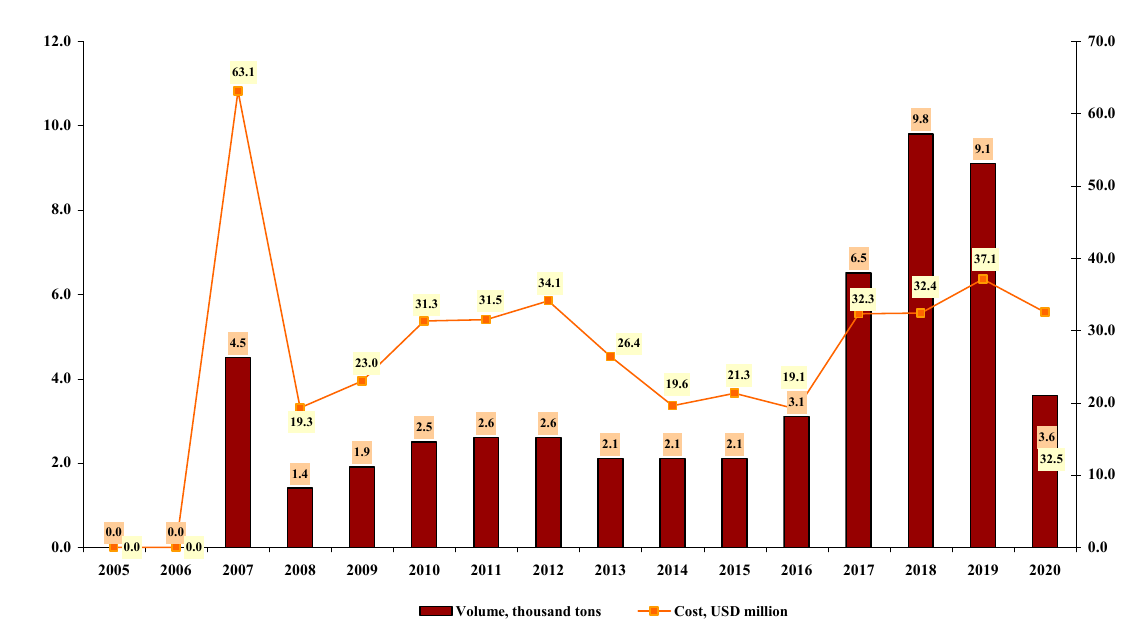
Figure 4. Dynamics of rapeseeds imports, USD without VAT. Source: State Statistics Service of Ukraine.